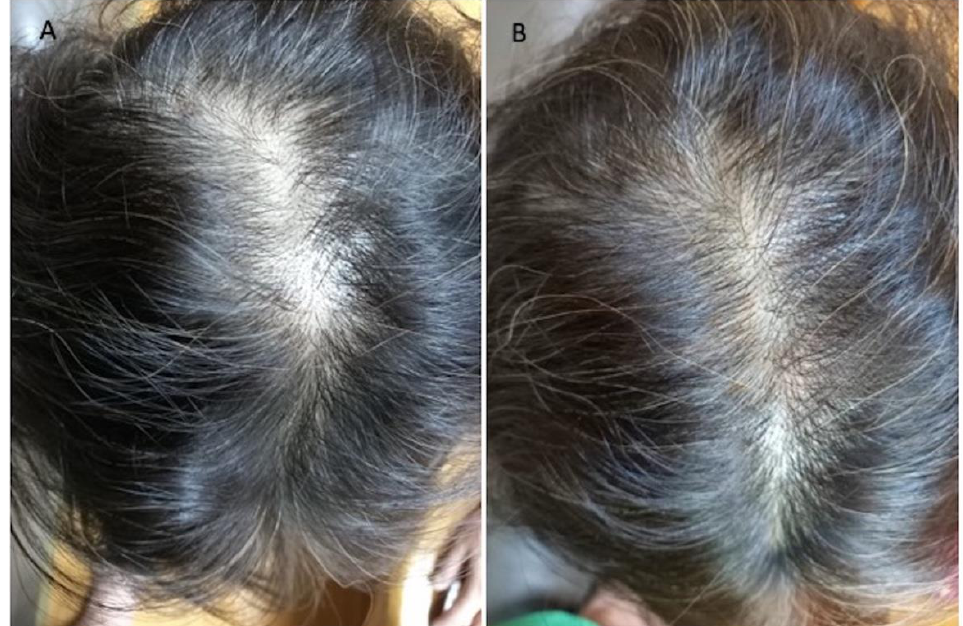
Figure 2. Asian female patients treated with MND and LLLT protocols. ( A ) Pre-operative view of the scalp of a 60-year-old female patient affected by AGA II according to Ludwig scale with hair loss localized in the frontal, temporal, and parietal area; ( B ) post-operative view at T1-16 wks after MND and LLLT treatment with detail of HR-G in parietal area.